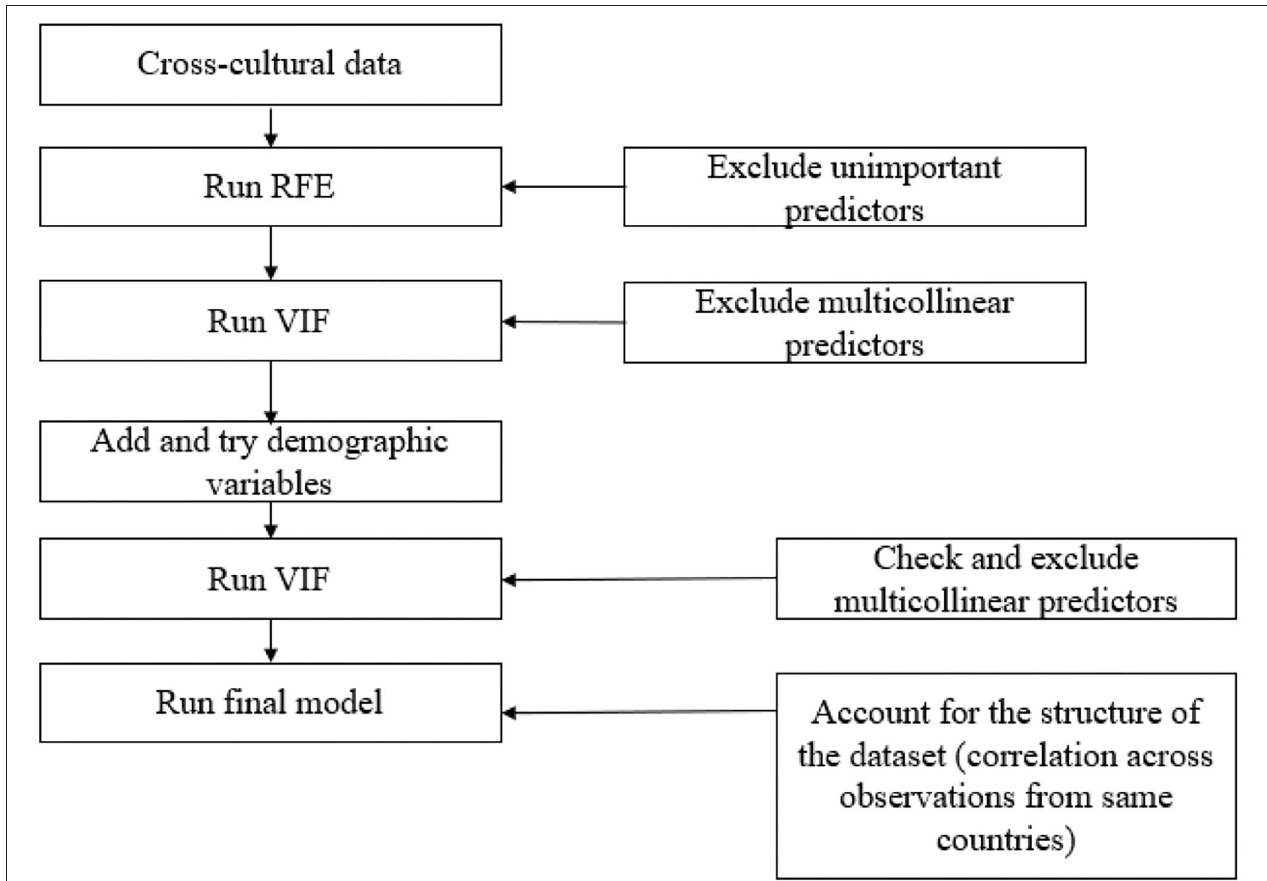
FIGURE 1 | Methodological steps of the